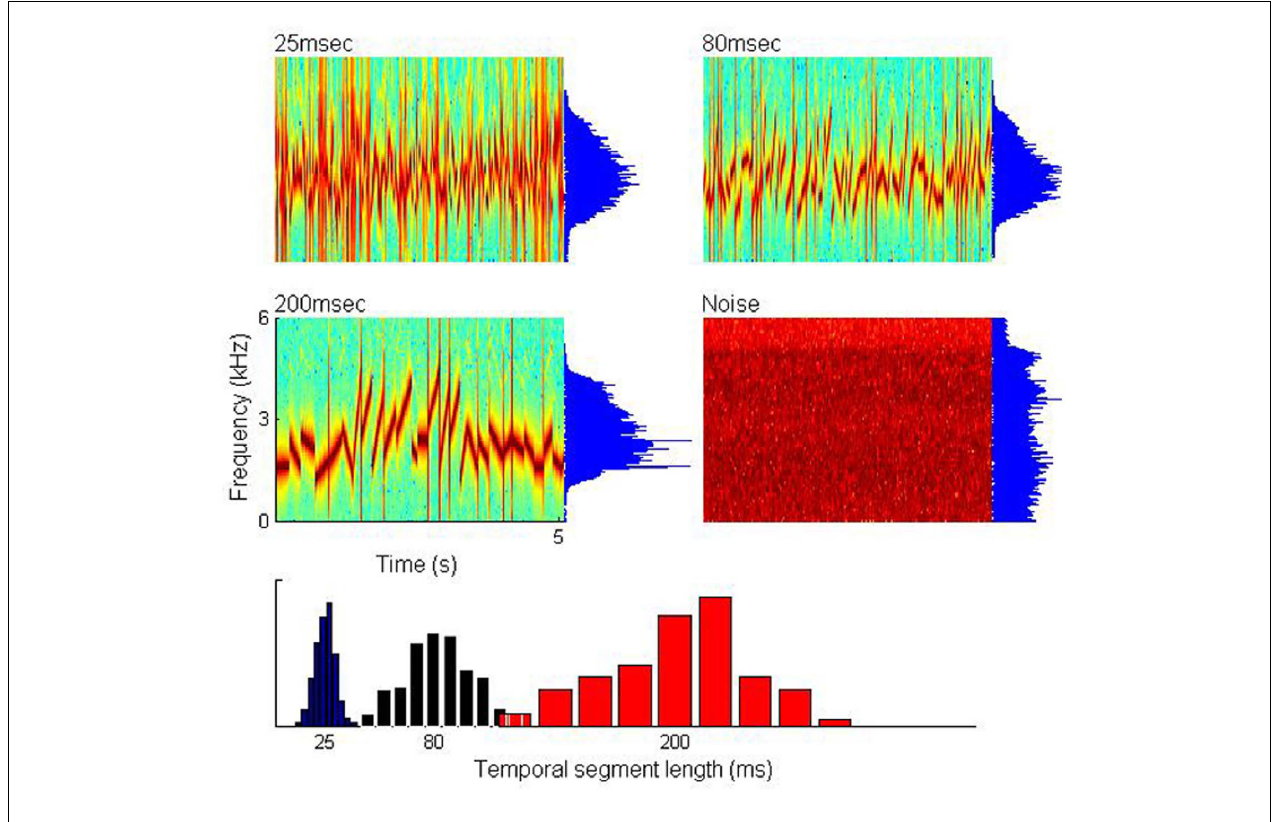
and 200ms) and one noise control stimulus. Lower panel: segment length distribution for the three stimuli (blue: ∼ 25ms; black: ∼ 80ms; red: ∼